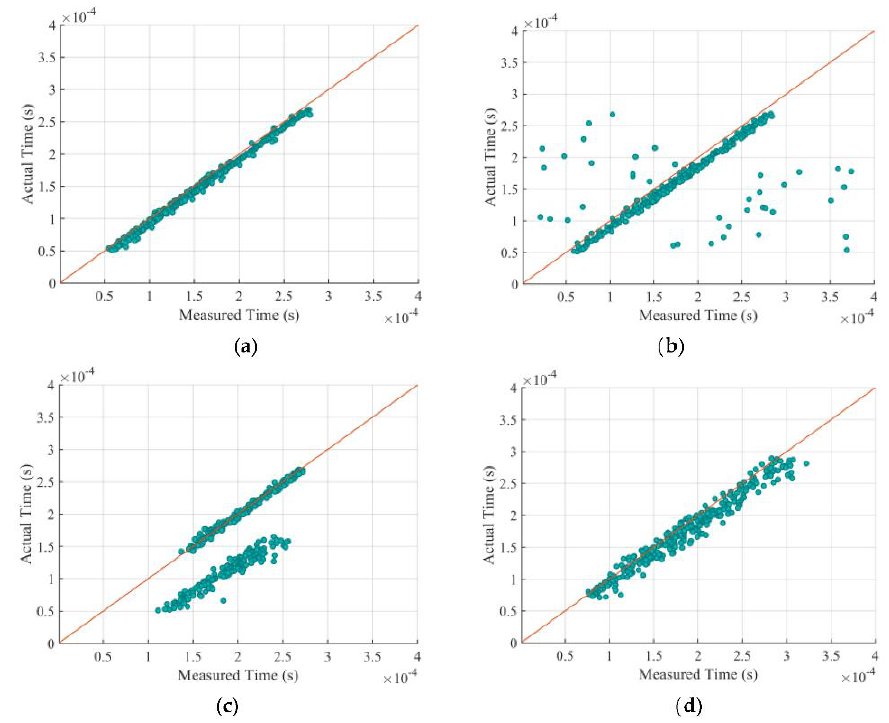
Figure 8. Distribution of measured values and the corresponding actual values on 5dB: ( a ) proposed; ( b ) STA/LTA; ( c ) AIC; ( d ) TKEO. Table 1. Mean Square Error and R-square determined by the four methods.